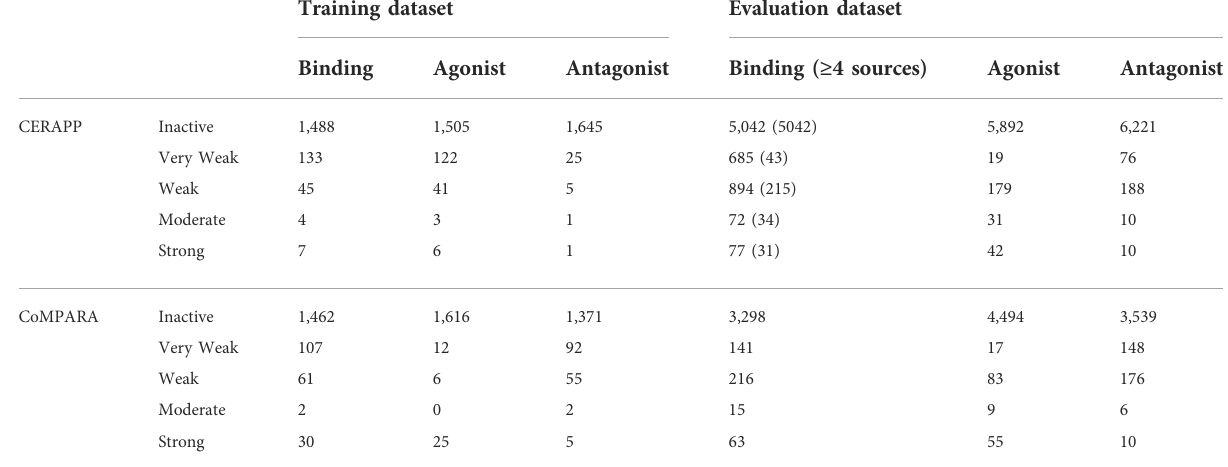
TABLE 2 Information for classi fi cation of receptor activity for the training and evaluation datasets.